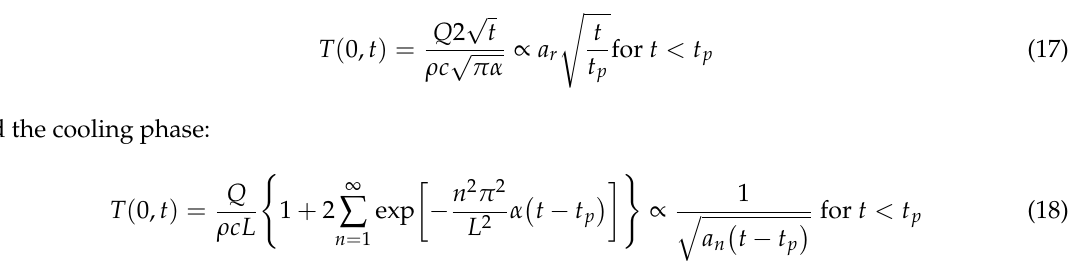
Figure 16. Nonlinear ultrasonic stimulated results thermography on a composite stiffened panel while conducting a sweep between 20 kHz and 30 kHz, with permission from 28 .